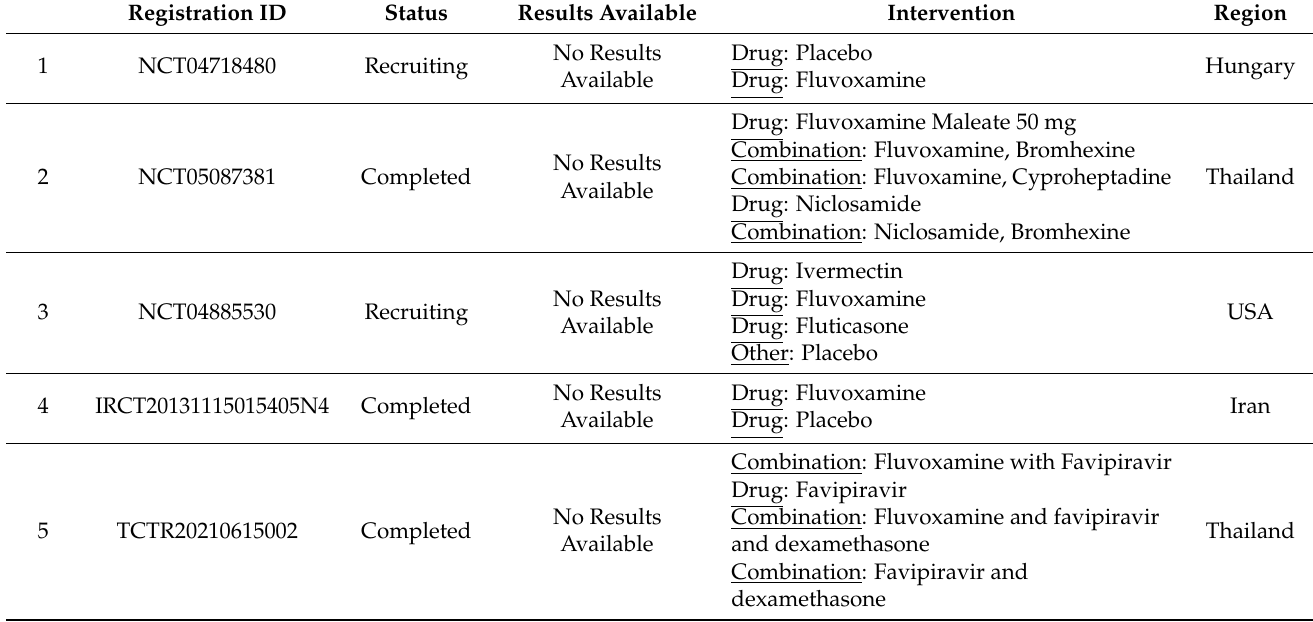
Table 2. Details of the “not included” randomized controlled trials identified in search of